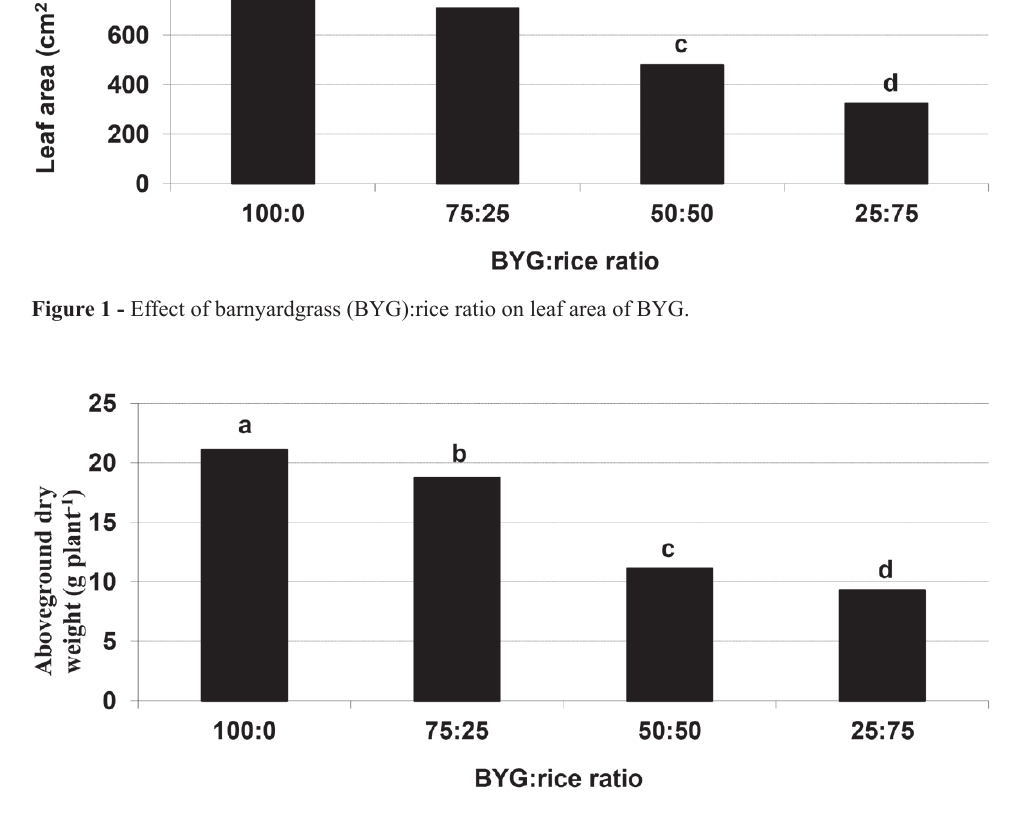
Figure 2 - Effect of barnyardgrass (BYG):rice ratio on aboveground dry weight of